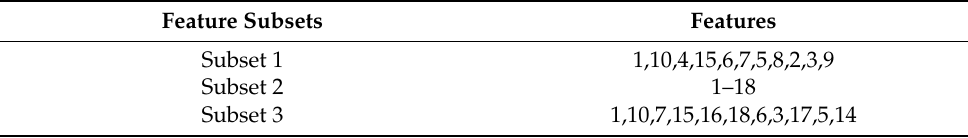
Figure 11. ( a ) RUL prediction of different feature subsets on Br1-3; ( b ) RUL prediction of different feature subsets on Br2-1; ( c ) RUL prediction of different feature subsets on Br3-3. Table 5. Different feature